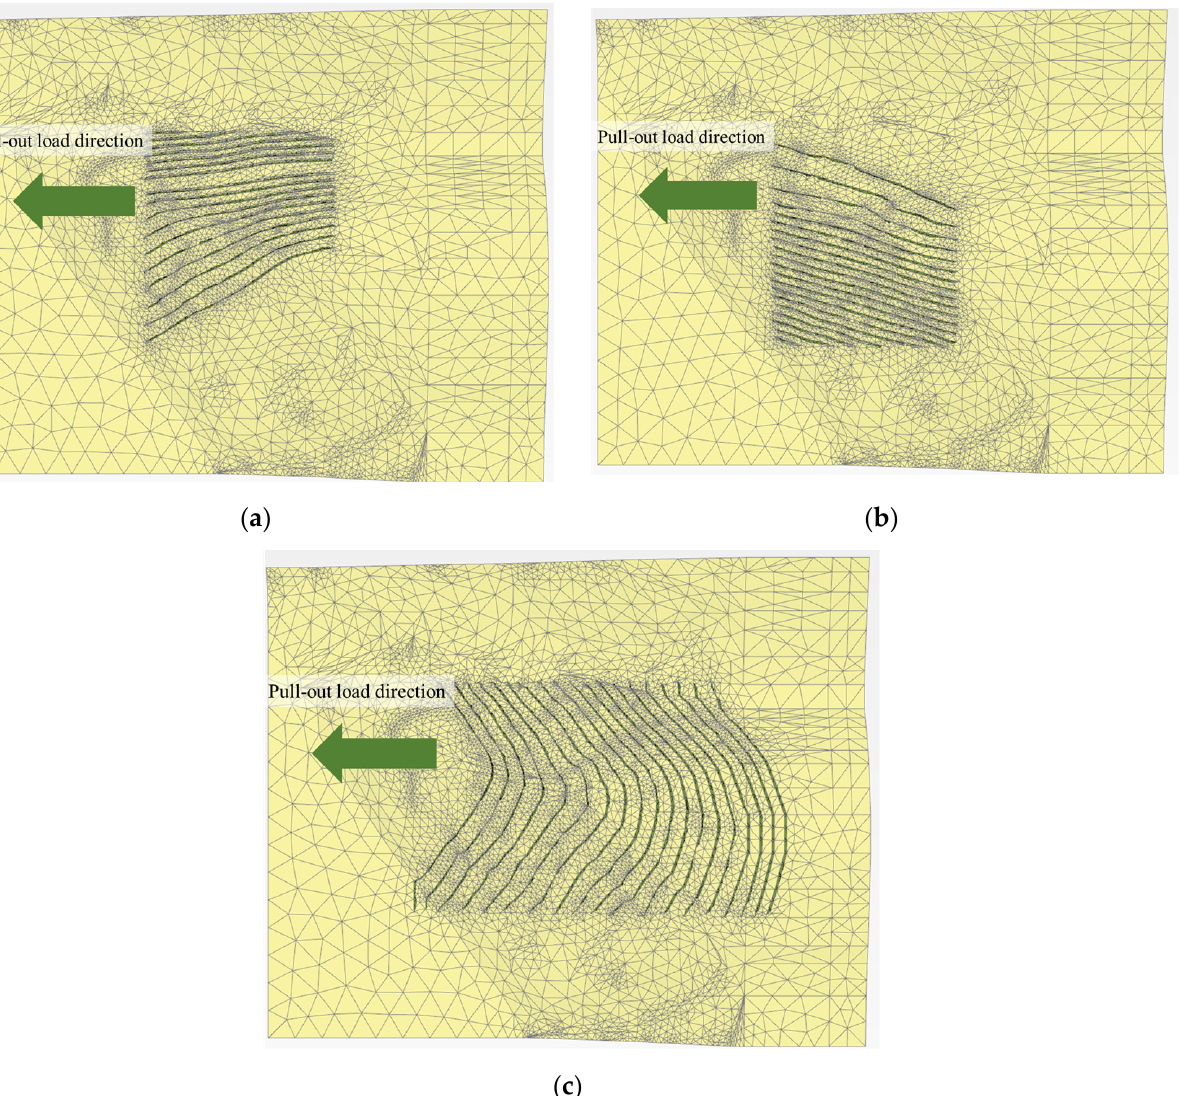
Figure 4. Plane view of an FE mesh for the rock joint: ( a ) joint set #1, ( b ) joint set #2, and ( c ) joint set #3.